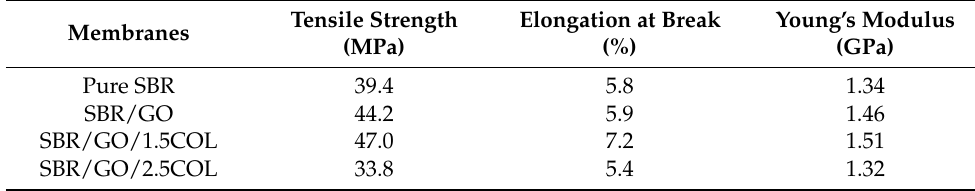
Figure 5. Mechanical stress–strain ( a ) and biodegradability ( b ) tests of SBR samples. Table 3. Mechanical test data of SBR samples. Table 3. Mechanical test data of SBR